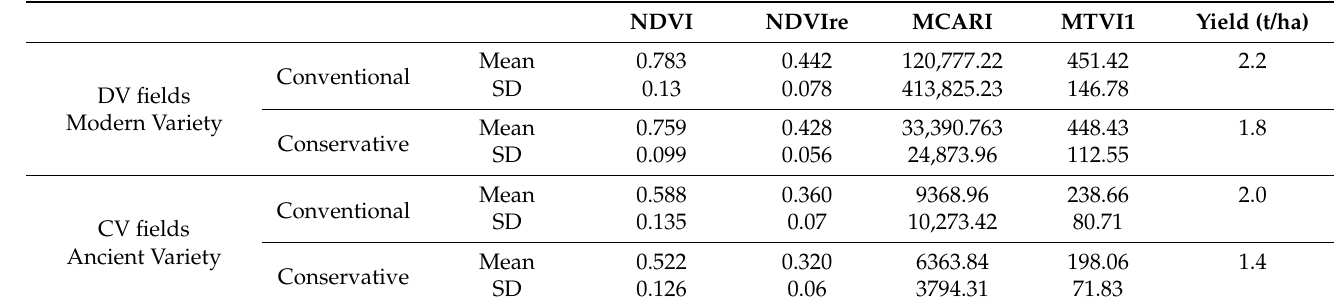
Table 3. Average values and standard deviation (SD) of vegetation indices by DV (with modern Anco Marzio variety and CA with old Saragolla Lucana landrace) and type of tillage management (conventional and conservative), as well as the respective grain yield.